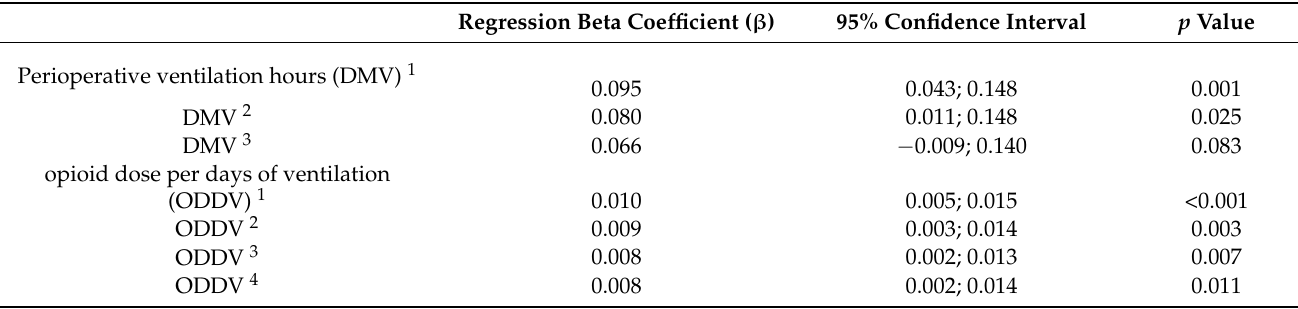
Table 3. Predictive value of perioperative mechanical lung ventilation (DMV) hours and perioperative opioid dose per days of ventilation (ODDV) for externalizing problem (EP) score by linear regression models.